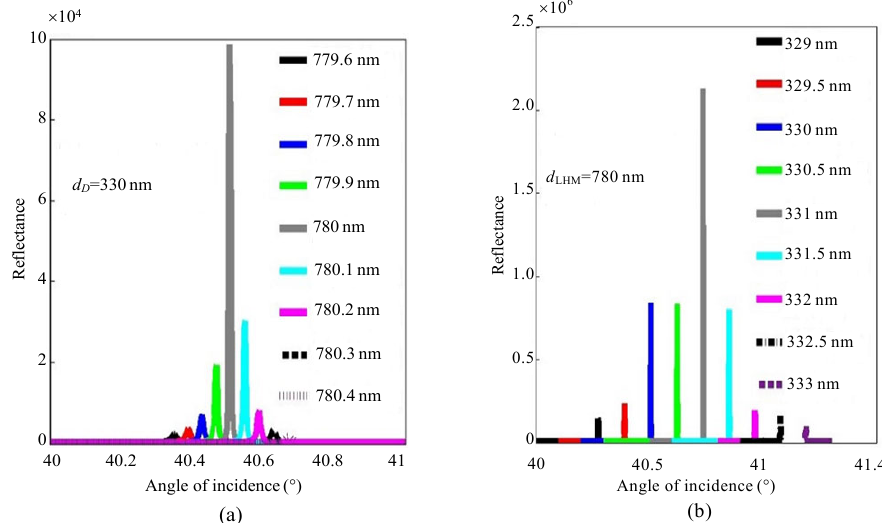
Fig. 3 Angular p-reflectance spectra for the arrangement prism/LHM/Dielectric layer/Au, when changing (a) for different LHM layer thickness from 779.6 nm to 780.4 nm with a fixed dielectric layer set to be 330 nm, and (b) for different dielectric layer thickness from 329 nm to 333 nm with a fixed LHM thickness set to be 780